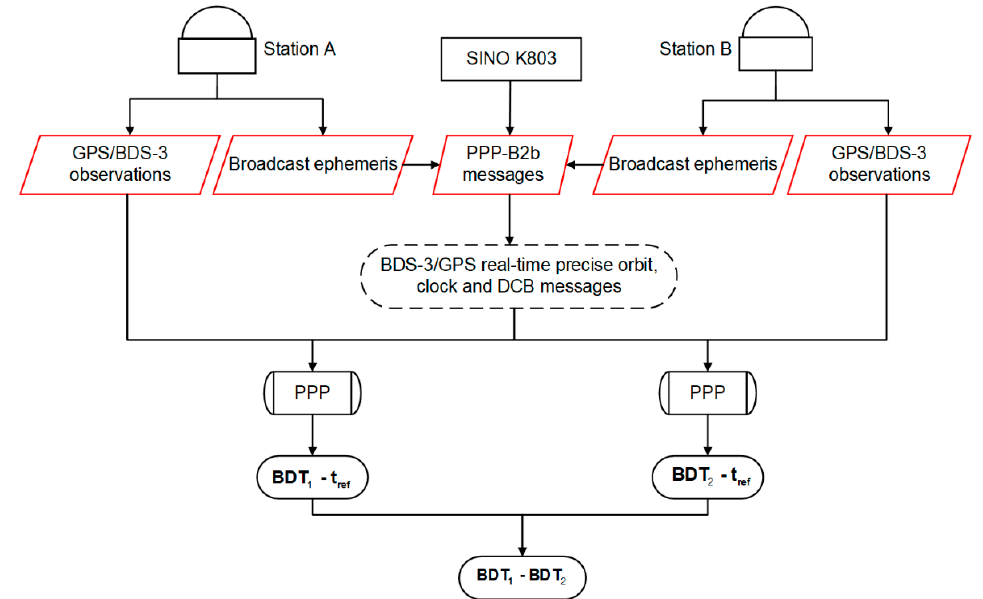
Figure 1. Principle of B2b-RTPPP.